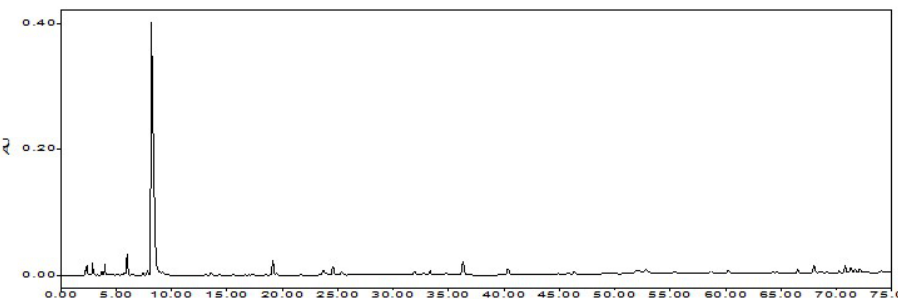
Figure 5. The chromatogram of capsaicinoids.